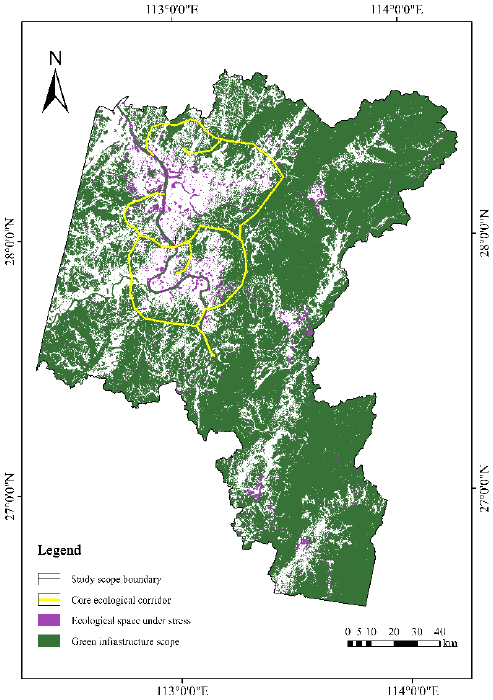
Figure 4. Stressed green infrastructure in the “no planning control” scenario in 2030.